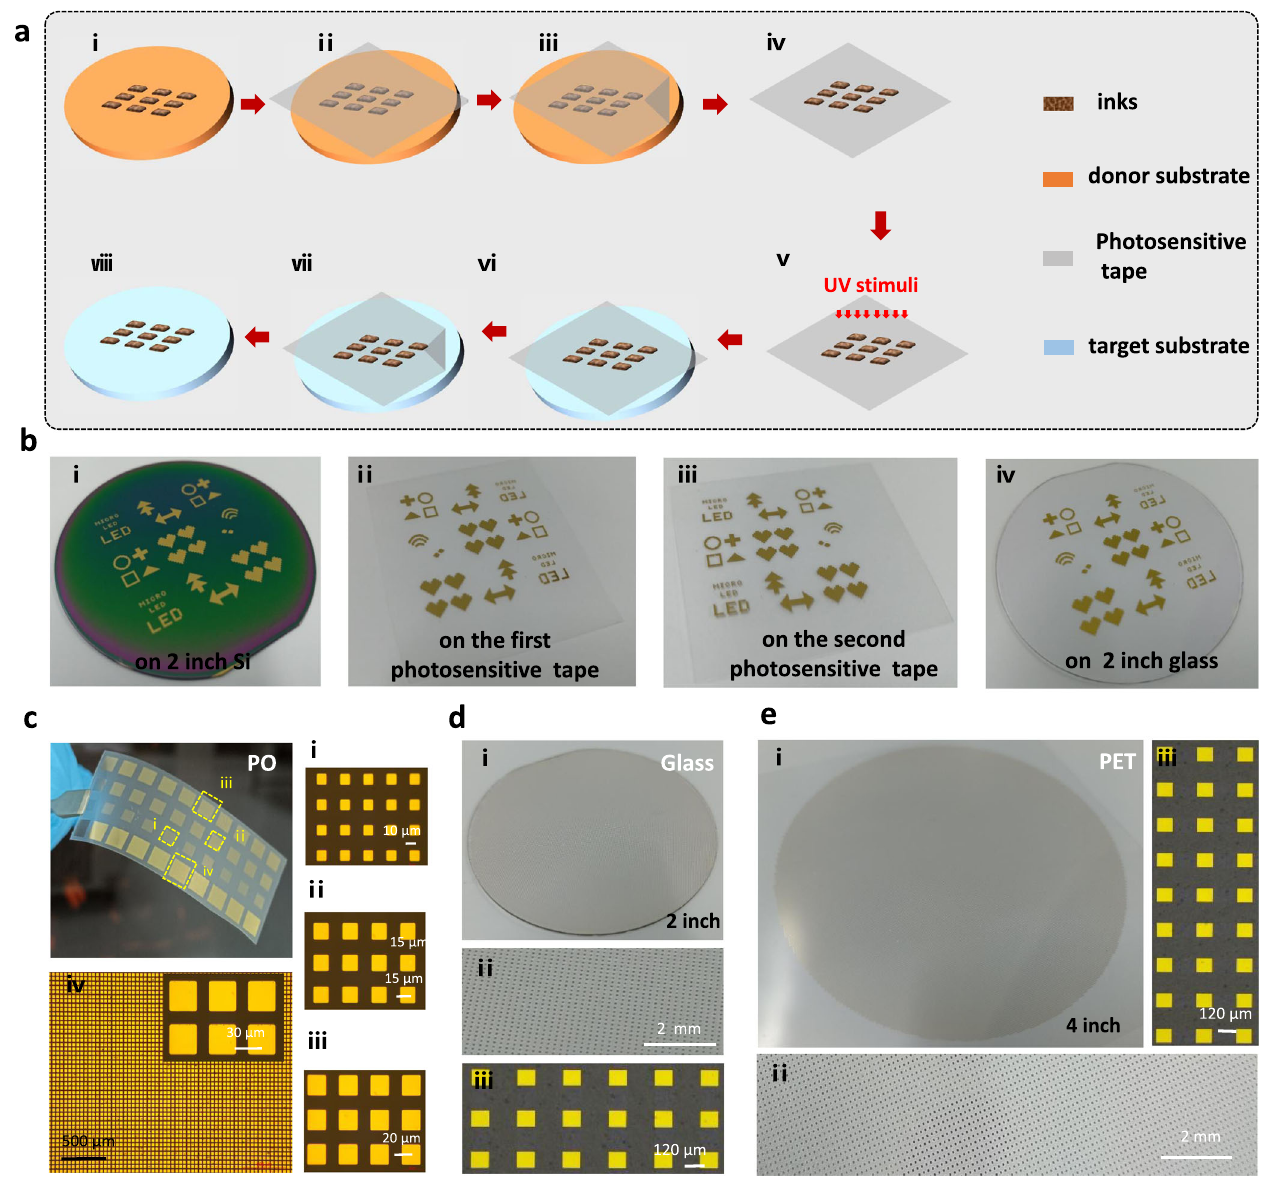
Fig. 3 Wafer-scale transfer printing. a Proposed wafer-scale micro-assembly procedure based on the photosensitive adhesive. b Optical images of the original gold nanomembrane inks on a 2-inch silicon (i), the gold nanomembranes picked up by the fi rst photosensitive polymer tape (ii), the gold nanomembranes transferred to the second photosensitive tape (iii), and the gold nanomembranes transferred to a glass substrate (iv). c Optical images of gold nanomembrane inks transferred onto a PO substrate. The feature size of the gold nanomembrane is ranging from 10 to 30 µm. The printing area of all gold nanomembrane arrays are <1 cm × 1 cm. d Photograph images of the large-area gold nanomembranes transferred to a 2-inch glass substrate. e Photograph images of the large-area gold nanomembranes transferred to a 4-inch PET substrate. For all transfer printing tests shown in ( b – e ), fl ood exposure time is 2.5